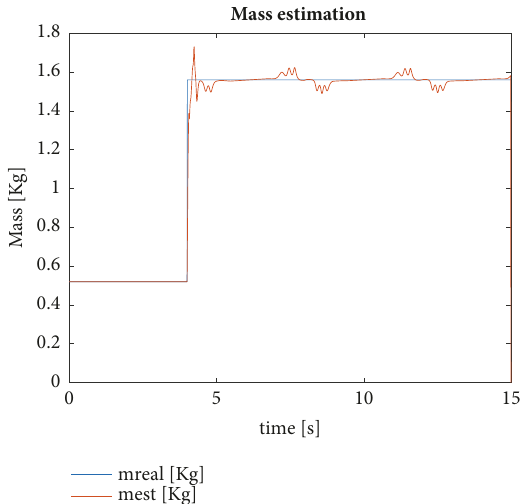
Figure 14: Mass obtained by the neural estimator.